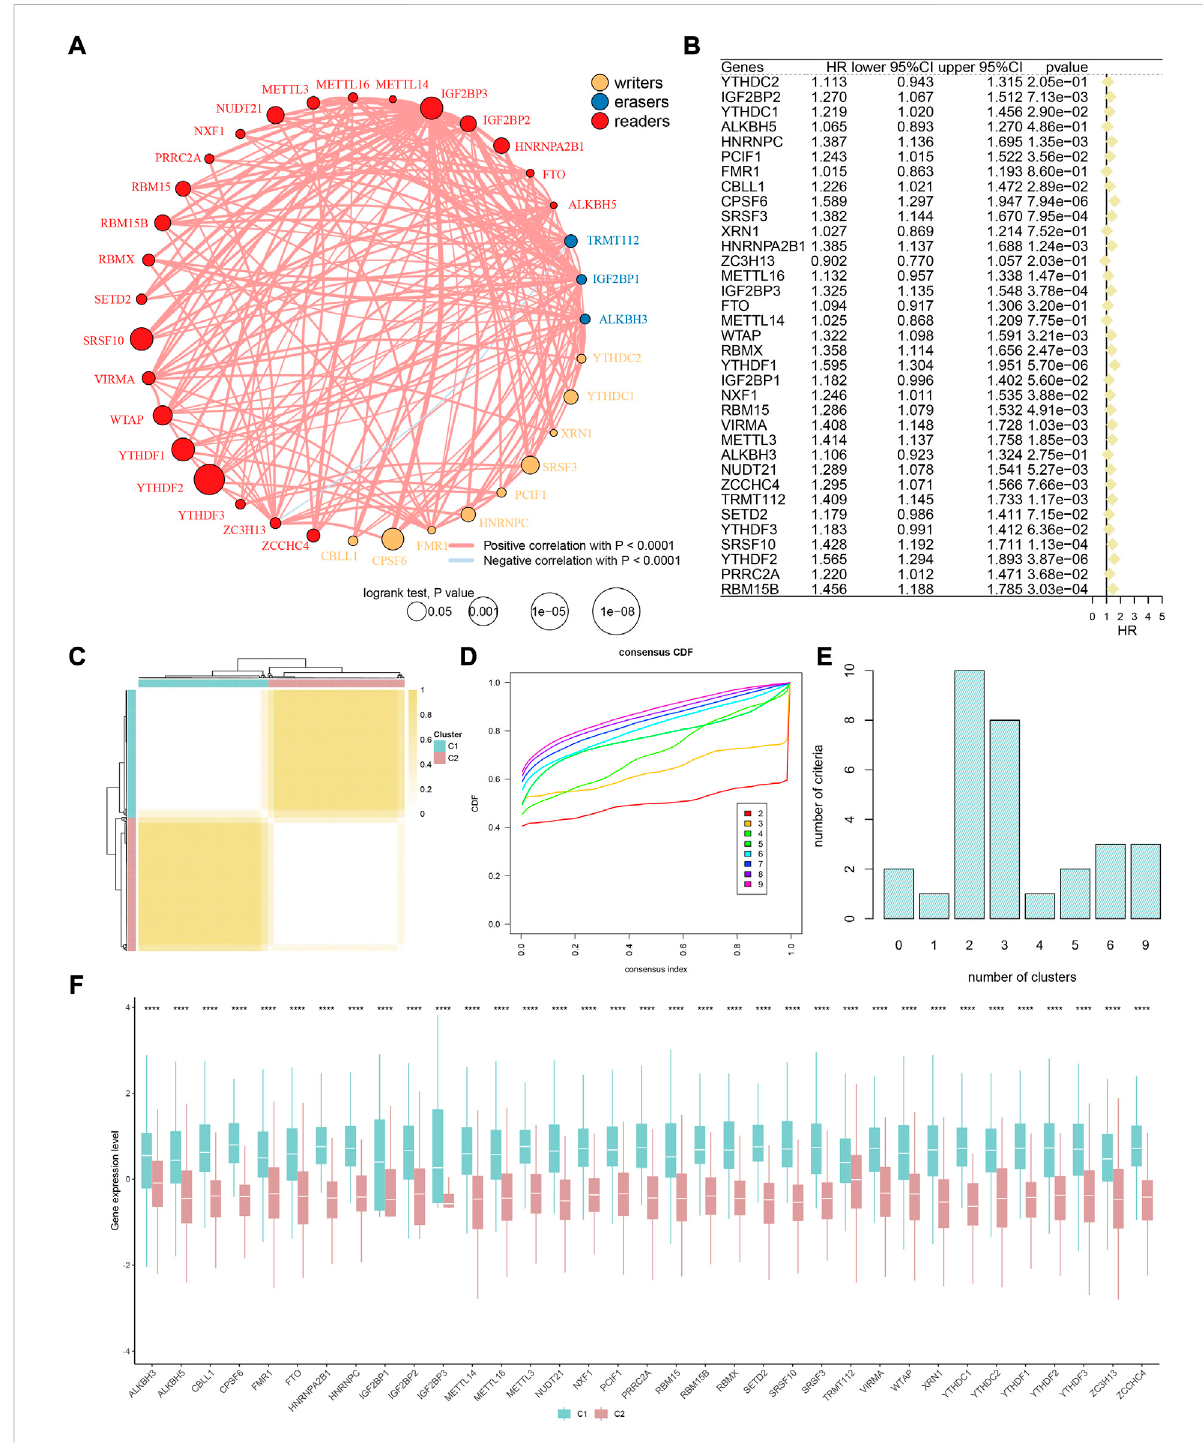
FIGURE 1 M6A methylation modi fi cation patterns in HCC. (A) Interaction between m6A regulators. Yellow dots represent writers, blue dots represent erasers, and red dots represent readers. Pink lines represent positive correlation between m6A regulators, and blue lines represent negative correlationbetweenm6Aregulators.Thesizeofeachcirclerepresentstheprognosticeffectofeachadjustmentfactorandisscaledbya p -value. (B) UnivariateCoxregressionanalysisof35m6Aregulators. (C) Consensusmatrixwhenk=2. (D) Consensuscumulativedistributionfunction(CDF) oftheconsensusmatrixforeachk(indicatedbycolors). (E) OptimalclusternumberbyK-meansclusteringandprogramNbClust. (F) Differenceinthe expression level of 35 m6A regulators between two m6A